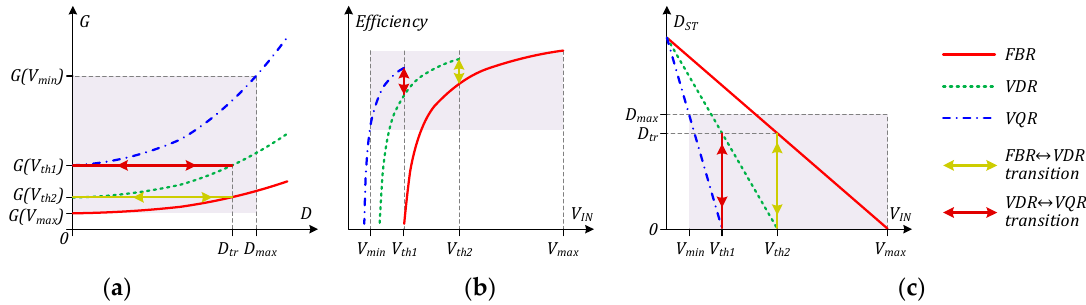
Figure 5. Idealized sketch of the operating principle of the high step-up DC-DC converter with front-end FBqZSI: ( a ) dc voltage gain curves and the transitions between them, ( b ) predicted efficiency curves shapes and the transitions between them, and ( c ) the linear dependencies of the duty cycle on the input voltage.